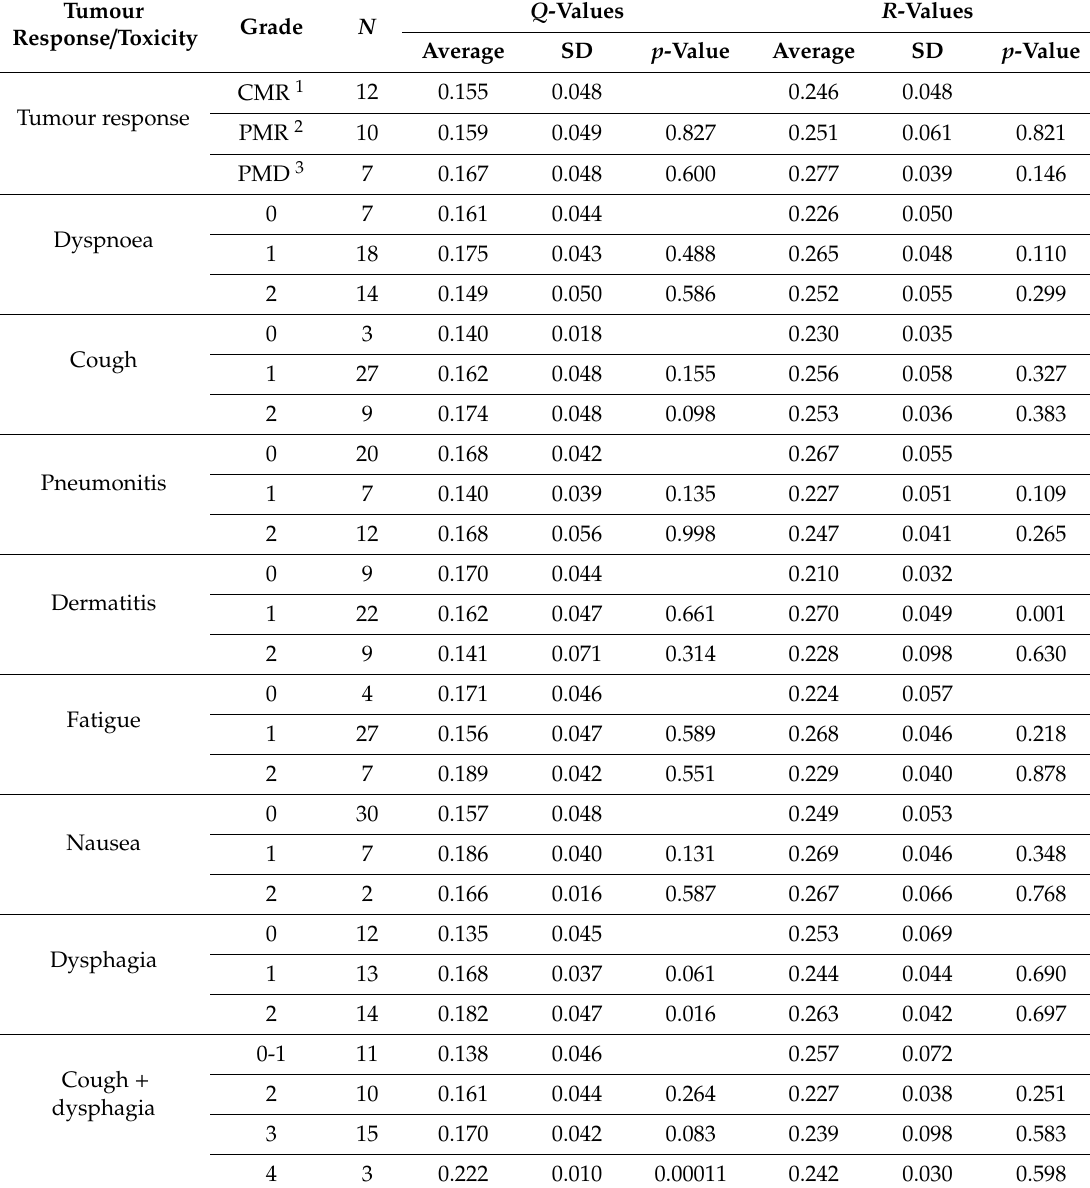
Table 3. Summary of the statistics and comparison of Q - and R -values for subgroups of patients with various metabolic response and normal tissue toxicity grades for seven types of